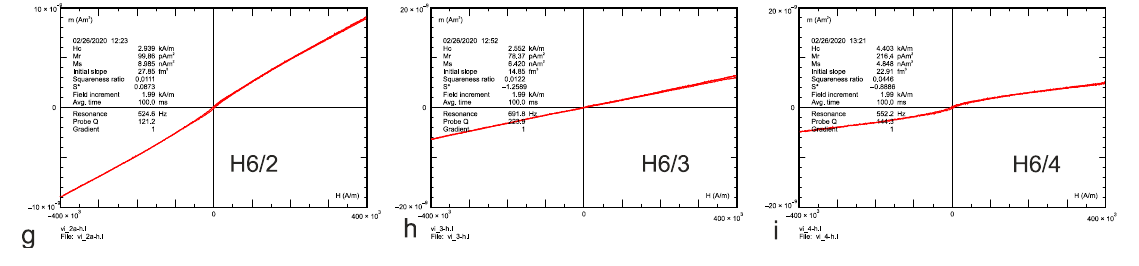
Figure 12. Hysteresis loops for all samples (each identified by symbols)—before slope correction: ( a ) data for an empty filter (EF), ( b ) for W1 dominant diamagnetic phase, ( c – e ) dominant ferromagnetic phase and ( f – i ) dominant paramagnetic phase.